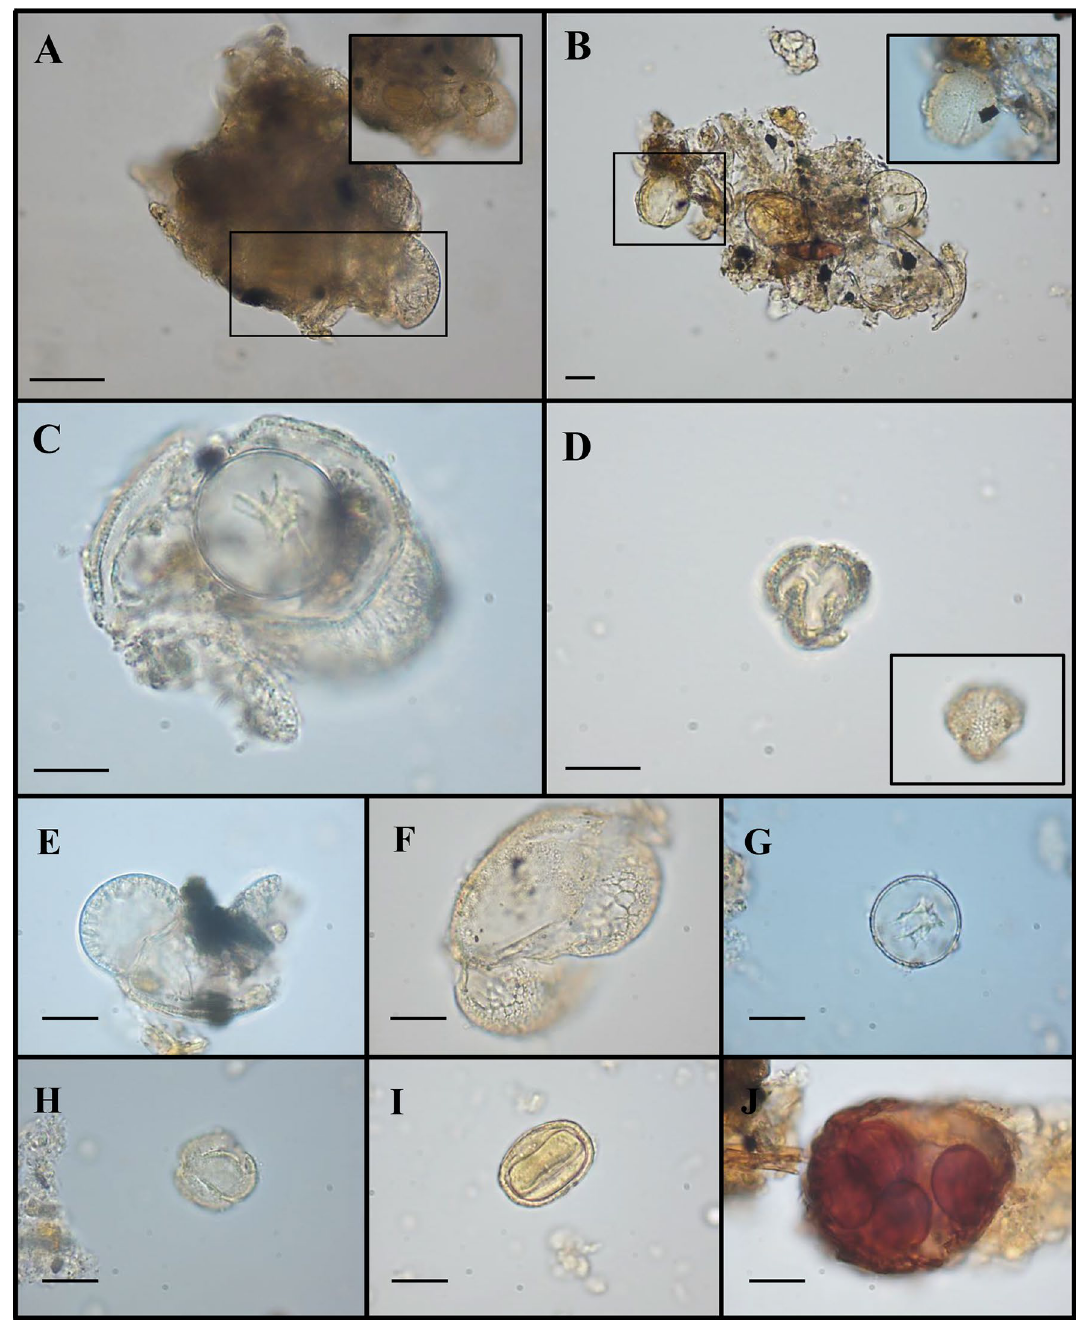
Figure 3. Plant micro-remains detected by morphological analysis in the dental calculus of CDD7 sample. Representative images obtained by light microscopy analysis were shown. Aggregates of pollen and spores ( A , B ); Pinaceae and Cupressaceae pollen grains ( C ); Brassicaceae pollen grain ( D ); Pinaceae pollen grains ( E , F ); Cupressaceae pollen ( G ); Quercus deciduous pollen ( H ); Alchemilla type pollen ( I ); sporangium of Monylophyta ( J ). The scale bar indicates 15 µm. Small flecks of calculus still attached to microparticles can be observed in some